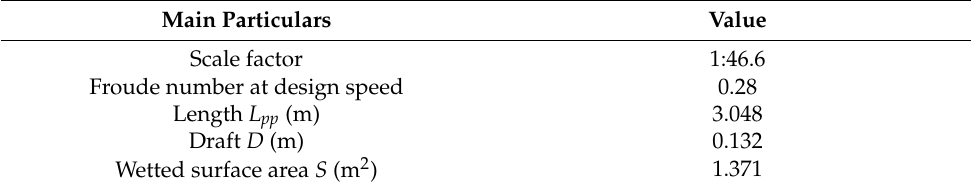
Table 1. Geometric